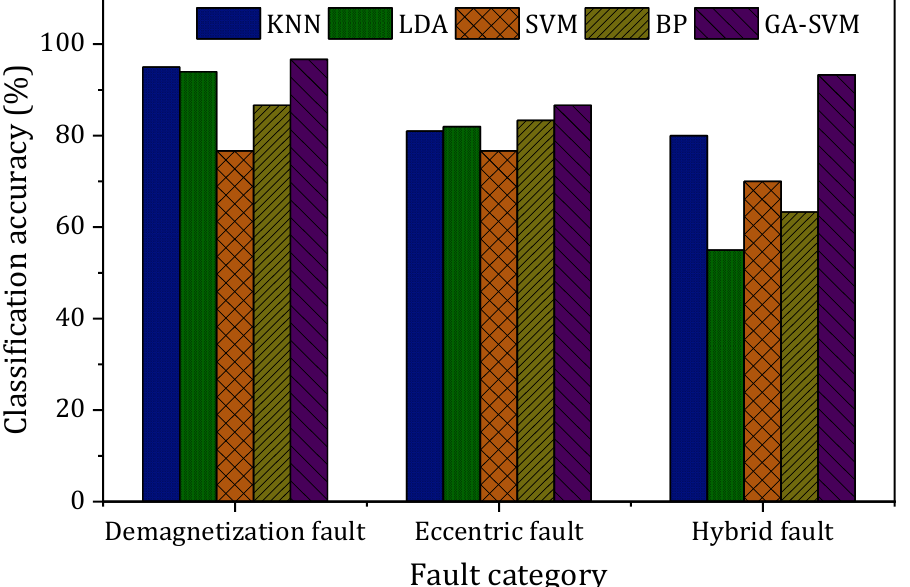
Figure 12. Comparison of the classification accuracy of commonly used fault classification models.